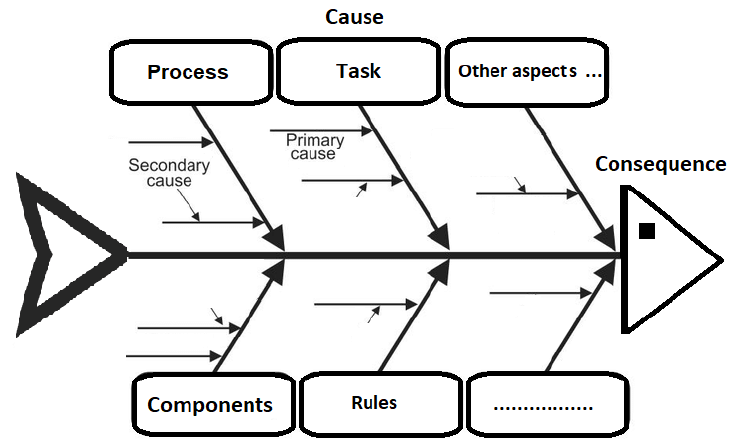
Figure 1. A generic representation of the Ishikawa diagram (or fishbone